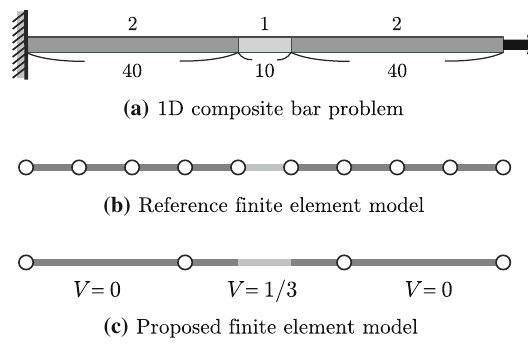
Fig. 5 Tensile problem of bar comprising two different materials